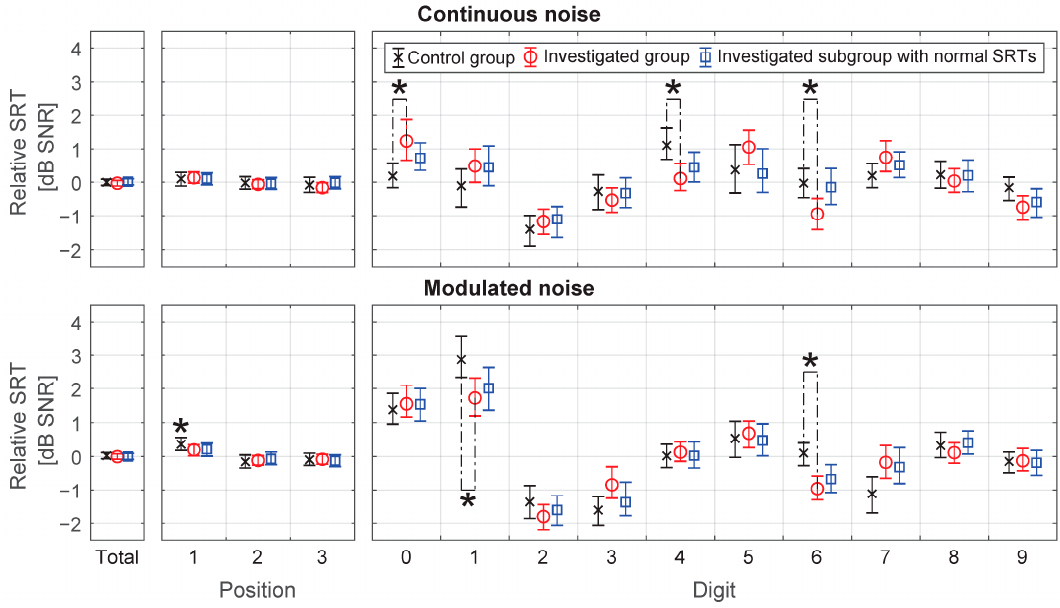
Figure 5. Position-specific and digit-specific speech reception thresholds (SRTs) for continuous and modulated noise. The Y-axis represents SRT normalized for individual differences (after correction for ear SRT). The 95% confidence intervals are marked by whiskers. Statistically significant differences at the level of p = 0.05 calculated applying Bonferroni correction for multiple comparisons were marked (*).